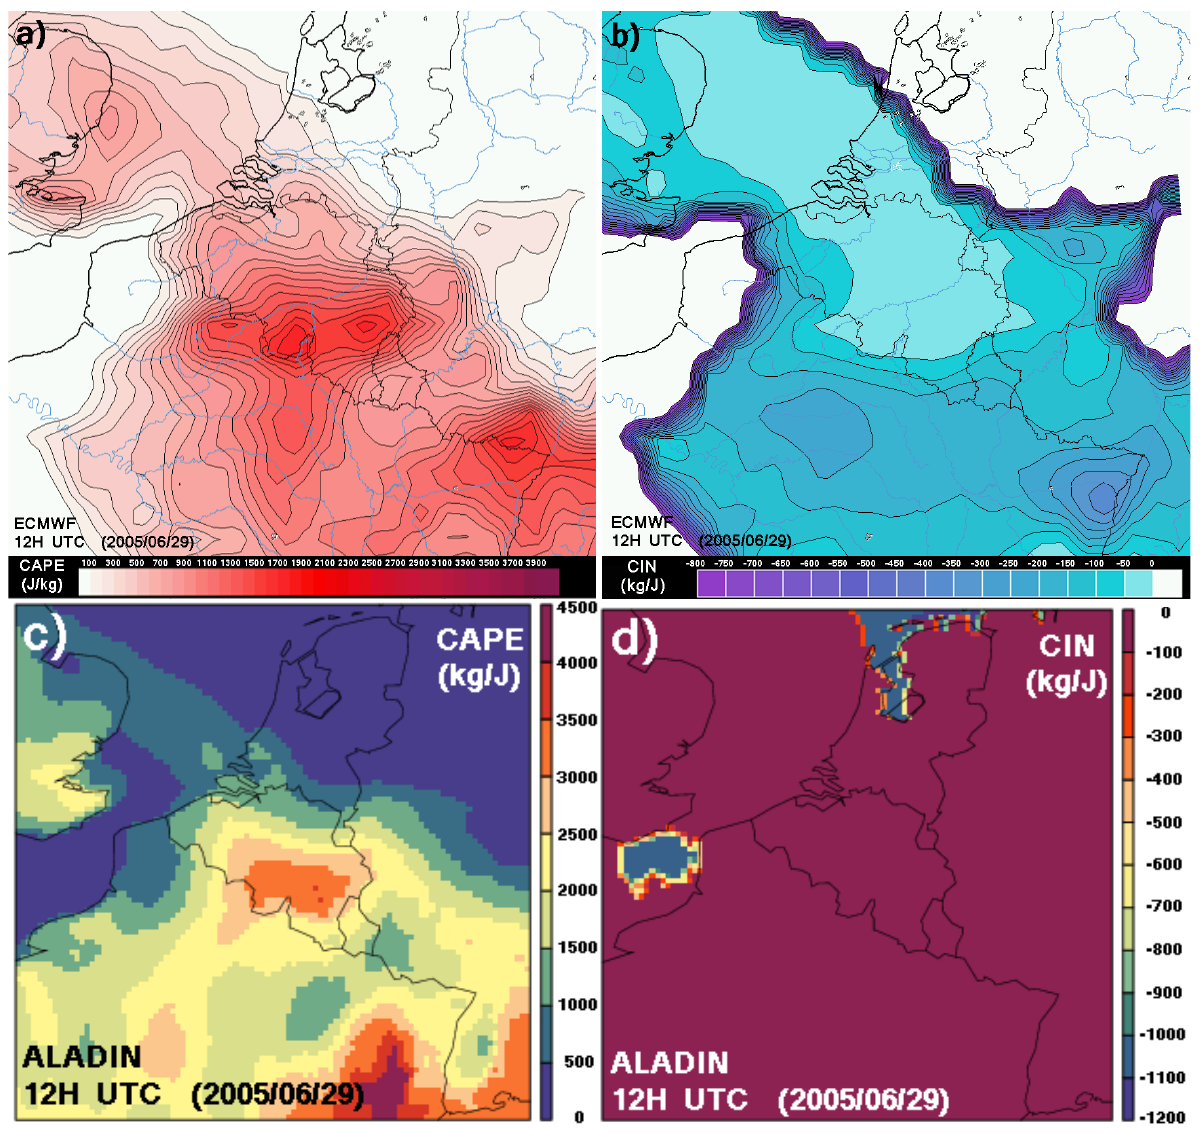
Figure 4. Estimations of (a) CAPE and (b) CIN from ECMWF model at 12:00UTC (29 June 2005). ECMWF model started at 00:00UTC (29 June 2005). Estimations of (c) CAPE and (d) CIN from the analysis of ALADIN regional model at 12:00UTC (29 June